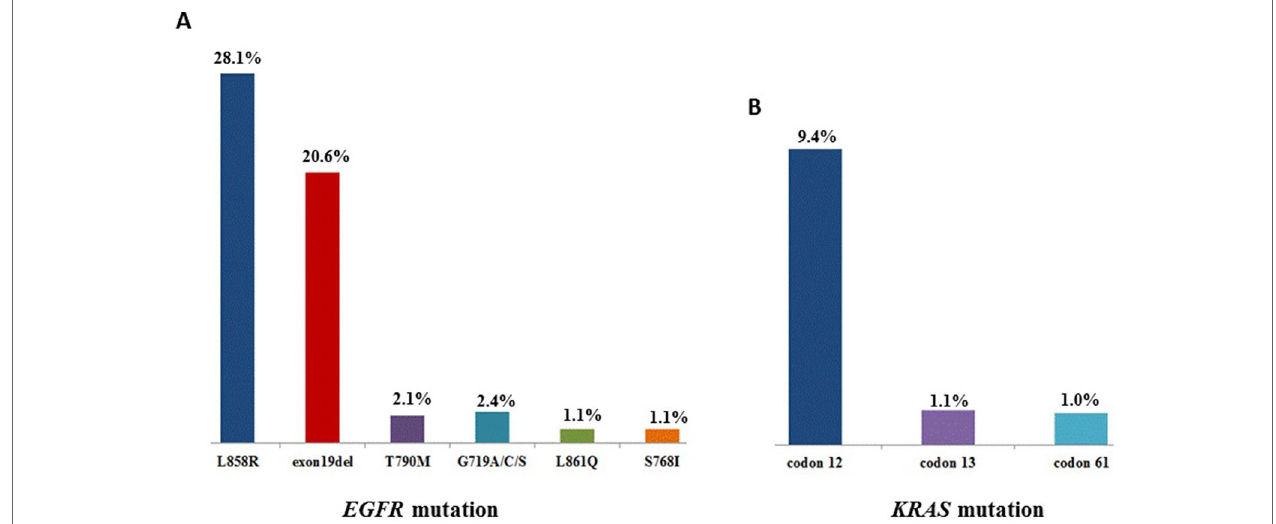
FIGURE 1 | (a) , The mutation sites and frequency of EGFR and (B) KRAS in 3,423 patients with lung